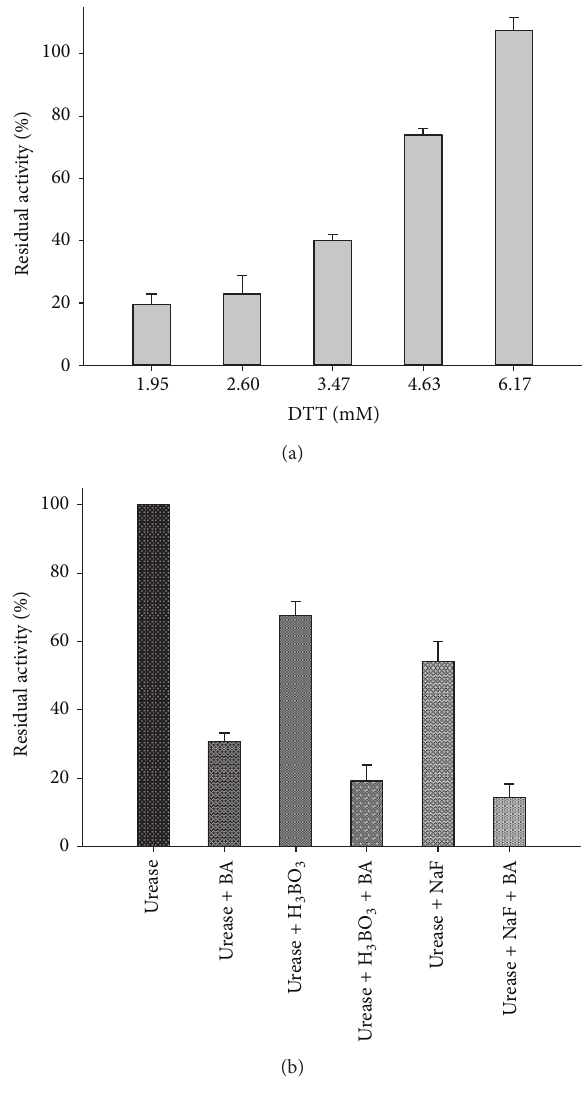
Figure 5: (a) DTT protection of urease against BA. Concentration of DTT (mM) is numerically given. (b) Protection of urease against BA inactivation by boric acid and fluoride. The results are expressed as means ± SD of the data from triplicate